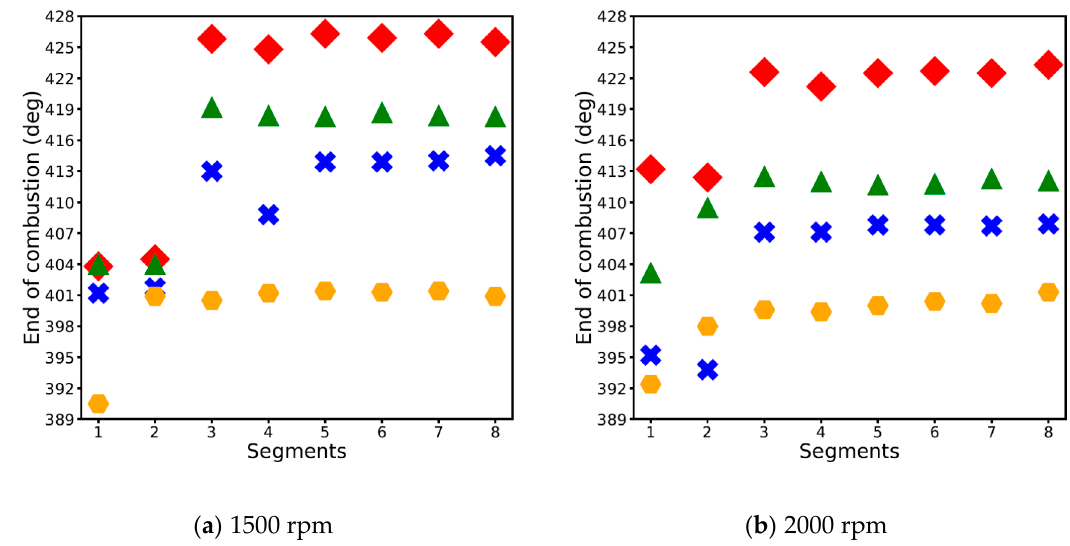
Figure 12. End of combustion at all loads in each stage at ( a ) 1500 rpm and ( b ) 2000 rpm. The red thick diamond represents 100% load, the blue thick cross 50% load, the green triangle 75% load and the orange hexagon 25% load.